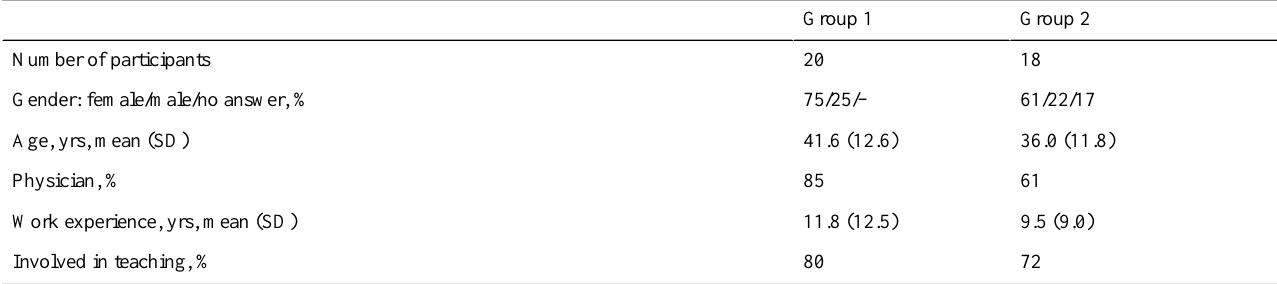
Table 1. Summary of the study participants’demographic